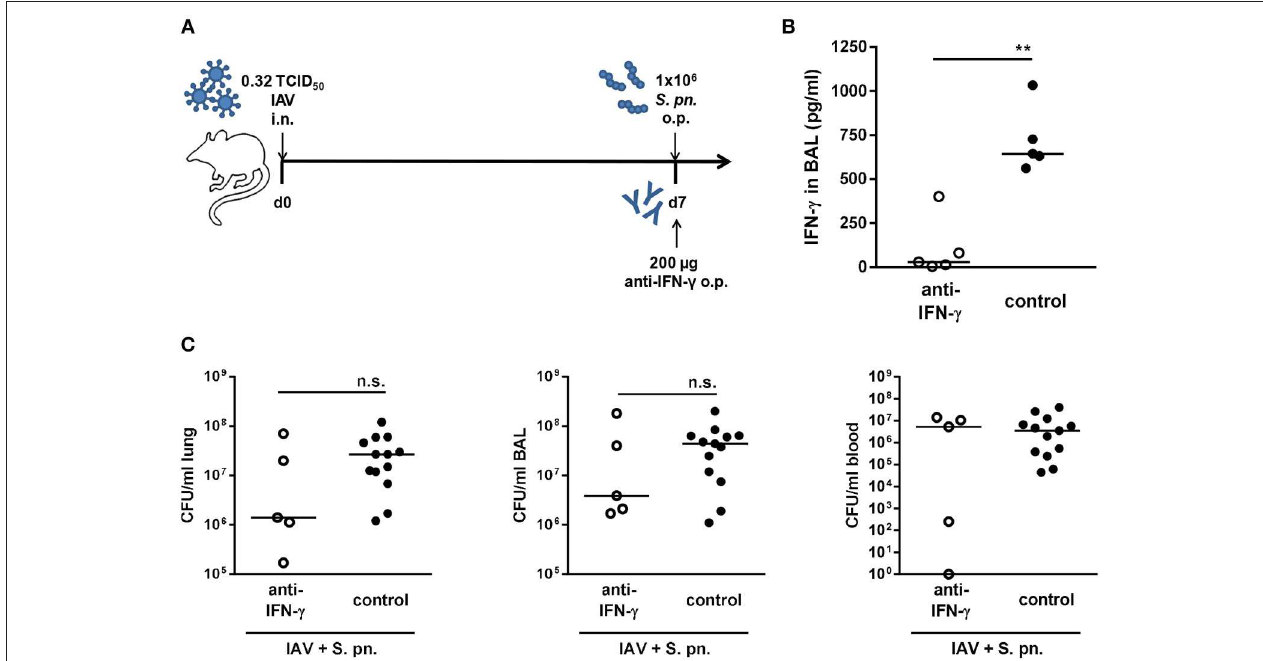
FIGURE 1 | Single IFN- γ neutralization during co-infection with 0.32 TCID 50 IAV and 1 × 10 6 CFU S. pn. Mice were infected intranasally (i.n.) with 0.32 TCID 50 IAV on day 0. On day 7, mice were treated with anti-IFN- γ antibody and infected with 1 × 10 6 CFU S. pn. oropharyngeally (o.p.). The control group was infected likewise and treated with an isotype IgG antibody. (A) Experimental setup. (B) IFN- γ protein levels in bronchoalveolar lavage (BAL) 24h post antibody treatment and S. pn. infection. (C) S. pn. bacterial counts in lung tissue, BAL and blood 24h post antibody treatment and S. pn. infection. Data are shown for individual mice and lines indicate the median/group. Controls in (C) are compiled from independent experiments. Statistical analysis was performed using the unpaired, one-sided Mann-Whitney test [n.s., not significant ( p > 0.05), ** p <